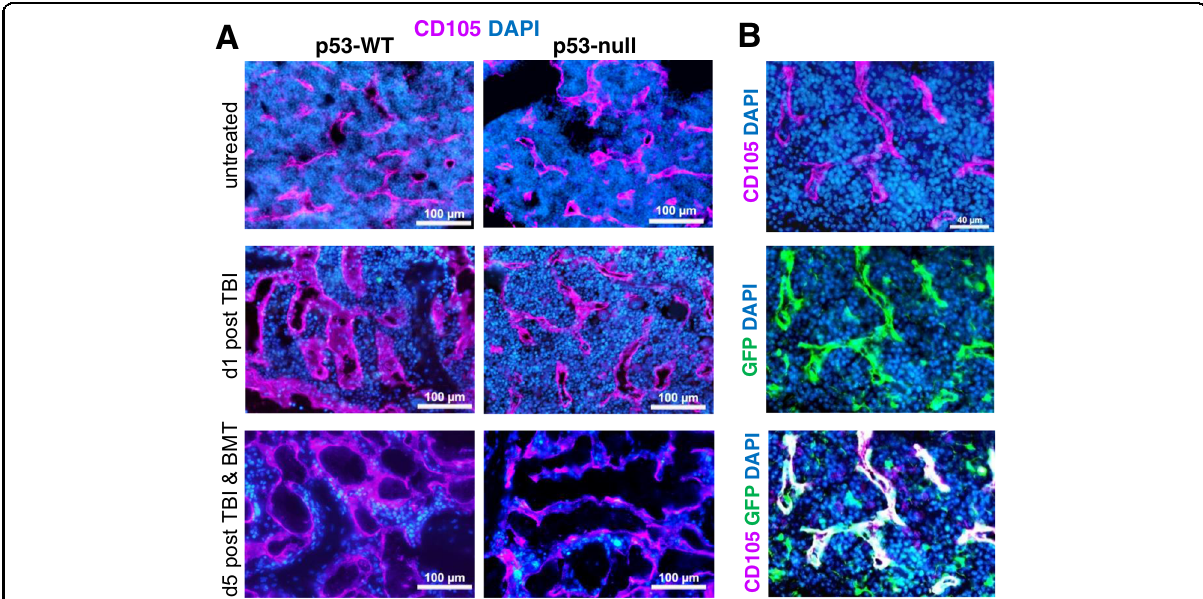
Fig. 5 Sinusoidal system in BM of p53-null mice is more damaged after IR and BMT compared with p53-WT mice. A Dynamics of BM sinusoidal system re-arrangement in p53-WT and p53-null mice after IR without or with BMT. Femoral BM sections were prepared at the indicated times from 53-WT and p53-null mice that were irradiated (13 Gy TBI) without or with subsequent BMT (5 × 10 6 cells from p53-WT mice 24 h post irradiation). Sections were stained for CD105 (magenta), a marker of sinusoid endothelium, and with DAPI (blue). Representative images from 2 – 3 mice of each genotype are shown. B The regenerated endothelium in irradiated p53-WT mice after BMT is exclusive of host origin. p53-WT GFP- expressing transgenic mice were irradiated (13 Gy) and then transplanted with syngeneic GFP-negative BM cells 24 h post IR. Immuno fl uorescence was performed on BM sections collected 6 months after IR/BMT. Green – GFP, Blue – DAPI, Magenta – CD105 (sinusoidal endothelium marker). Representative images from two mice are